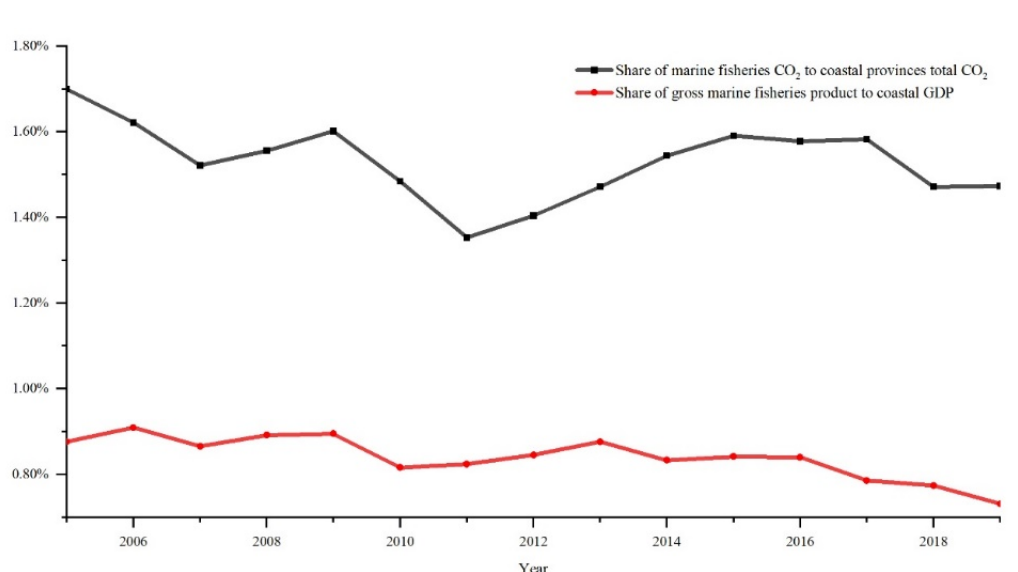
Figure 1. Comparison of the share of gross marine fisheries product to coastal GDP and the share of marine fisheries CO 2 to total CO 2 in coastal provinces. Note: Total CO 2 data from https://www.ceads.net.cn, accessed on 28 December 2022.